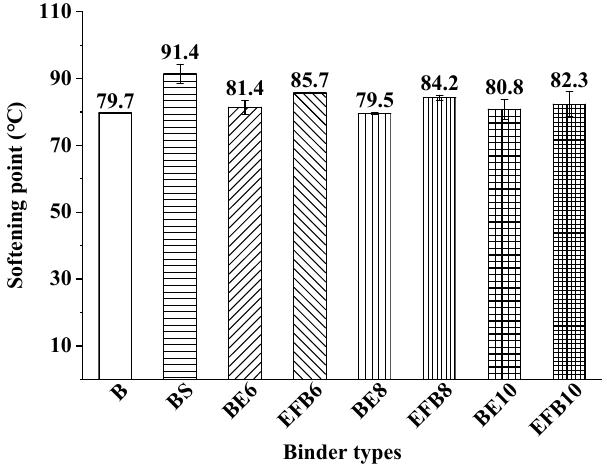
Figure 5. Test results: softening point.